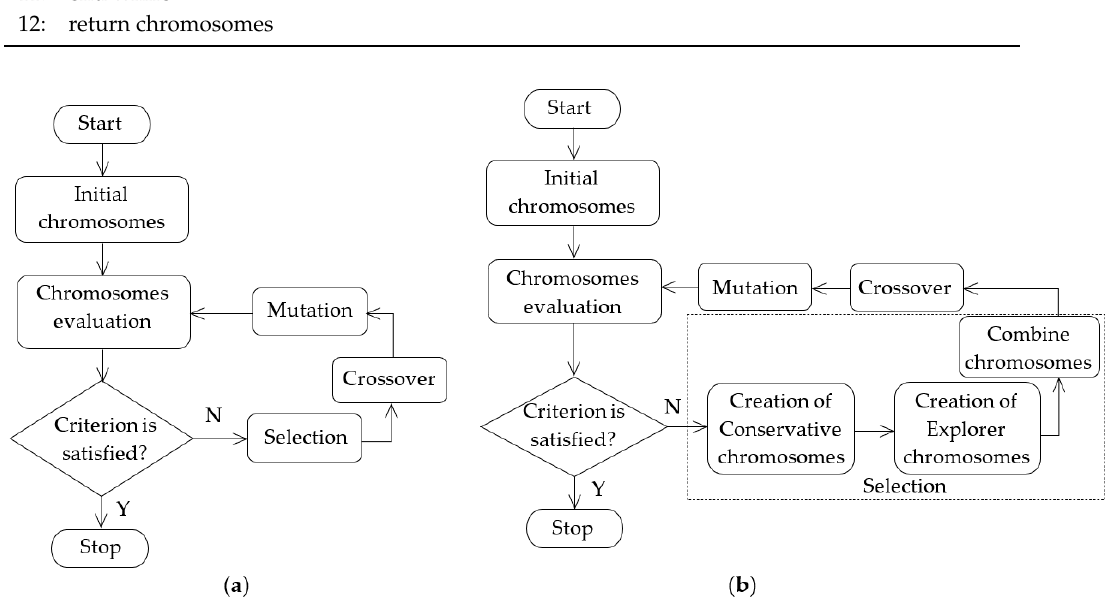
Figure 3. Flowcharts of traditional ( a ) GAs and ( b ) multiple-searching genetic algorithms (MSGAs).